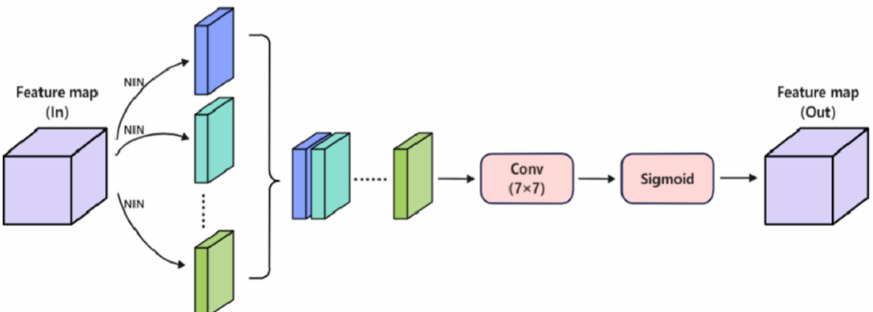
Figure 2. Schematic diagram of the spatial attention module. As mentioned in the text, the spatial attention module uses the “network in network” approach to extract information, while the obtained key information matrix is calculated by convolution and activation, to obtain the spatial attention weight